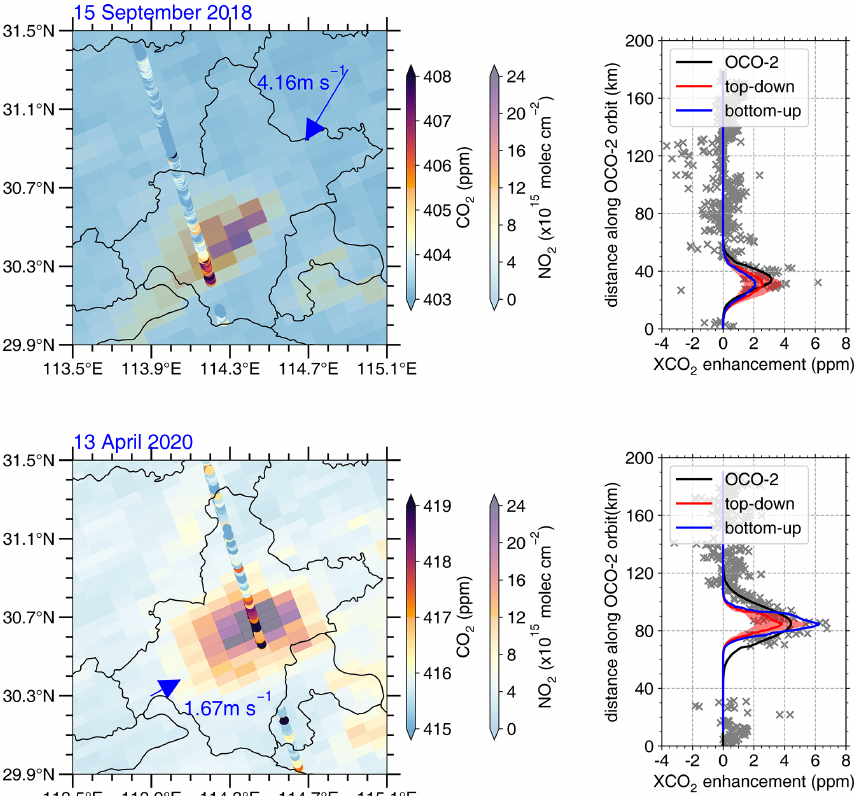
Figure 4. Simultaneous, co-located TROPOMI NO 2 and OCO-2 CO 2 observations over Wuhan (the left panel) on 15 September 2018 (top panels) and 13 April 2020 (bottom panels), the wind speed and direction on each day are shown. The dry-air mole fraction of CO 2 ( X CO 2 ) enhancements along the OCO-2 orbit are given for the corresponding day (the right panel). The grey crosses and black lines represent the OCO-2 observation. The blue lines denote X CO 2 enhancement predicted with bottom-up emissions, and the red lines (shading represents the uncertainty interval) denote that predicted with top-down CO 2 emission, estimated in this